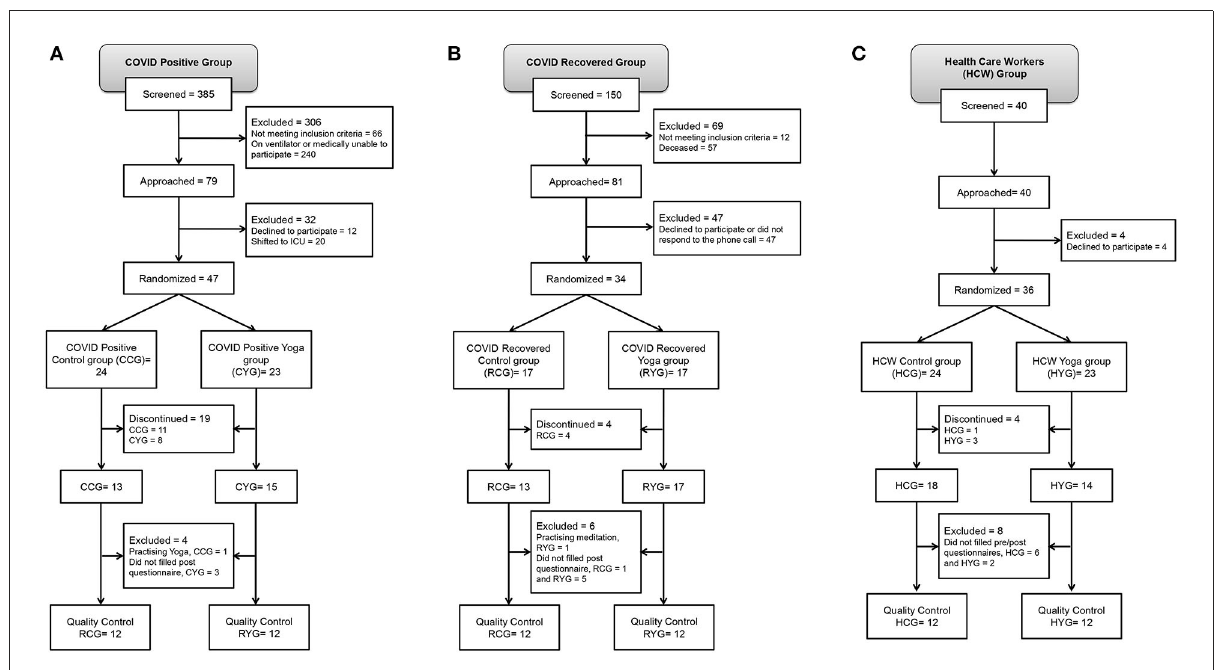
FIGURE1 Study participant recruitment as per CONSORT. (A) COVID-positive group, (B) COVID-recovered group and (C) HCW group.